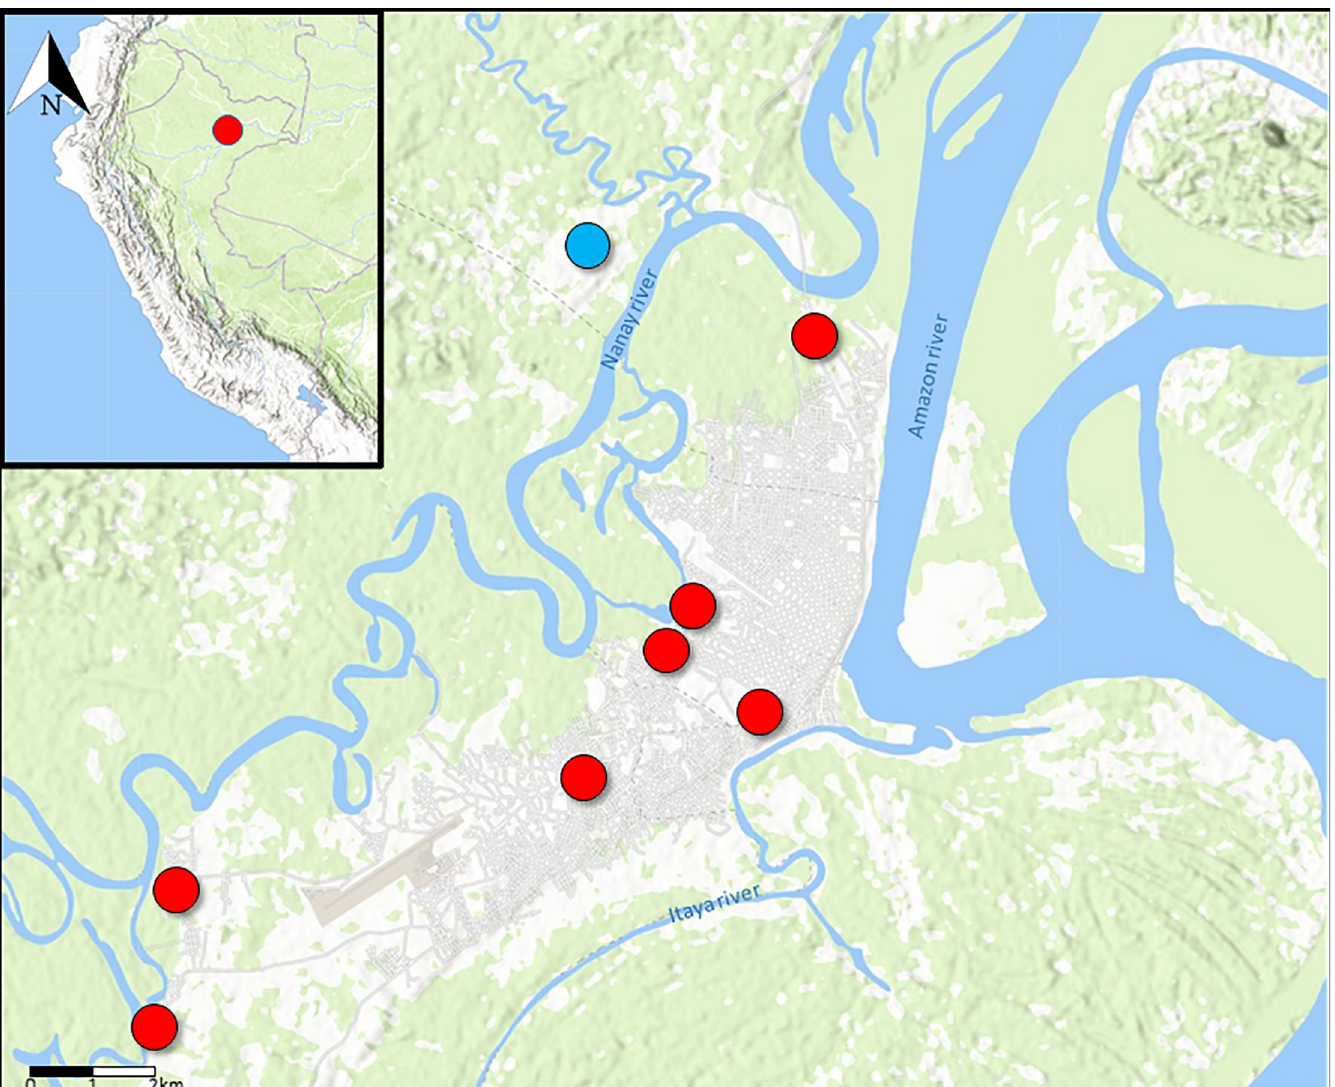
Fig 1. Study sites located in the region of Loreto, Peru. The insert shows the location of the health facilities where samples were collected in Iquitos. Red circles showed the sites for the passive surveillance studies. The community of Padre Cocha (Blue) was a site for the passive and active surveillance study. Map created using open data from OpenStreetMap, under ODbL, under CC BY 2.0